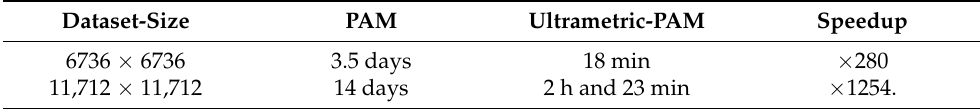
Table 9. PAM vs. Ultrametric-PAM speed of